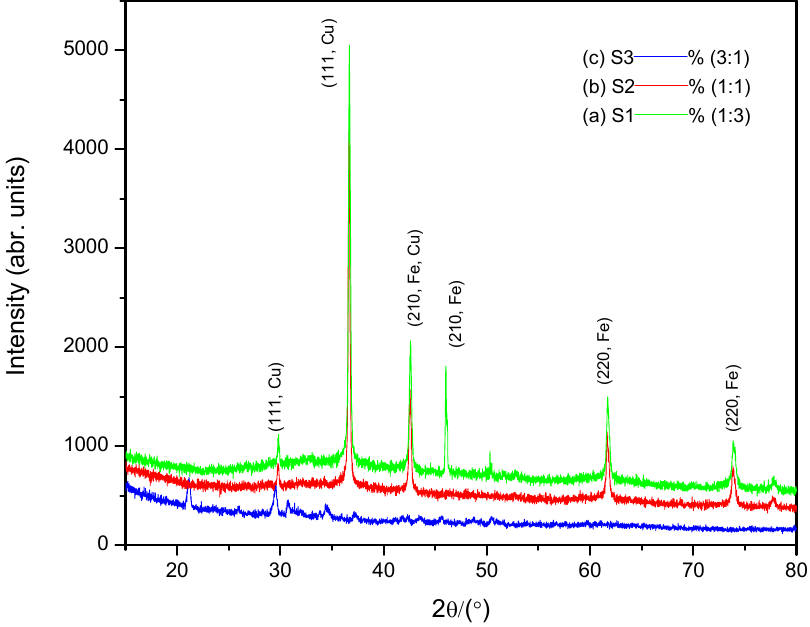
Figure 1. X-ray di ff ractograms of samples ( a ) S1, ( b ) S2, and ( c ) Figure 1. X ‐ ray diffractograms of samples ( a ) S1, ( b ) S2, and ( c ) S3.